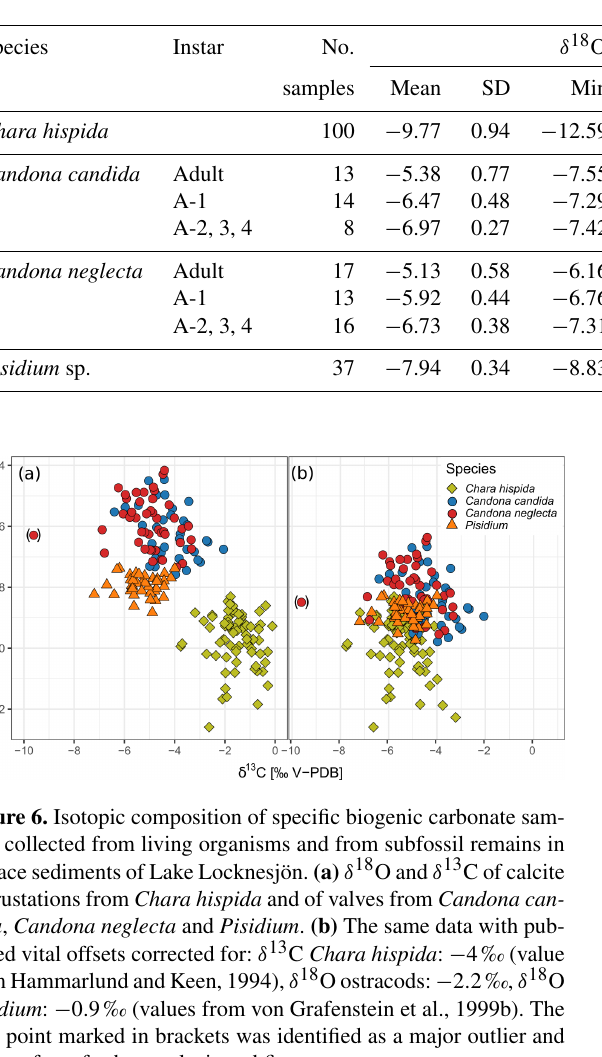
Table 1. Isotopic composition of specific biogenic carbonates from living organisms and from subfossil samples in surface sediments of Lake Locknesjön. Mean, standard deviation (SD), minimum, maximum and range of δ 18 O and δ 13 C values, as well as the number of samples are presented for Chara hispida , Candona candida , Candona neglecta and Pisidium sp. All values are reported in ‰ relative to V-PDB. Note that these are the measured values without a correction of vital offsets. The results of individual sample measurements are available in the Pangaea database, see Sect. “Data availability”.